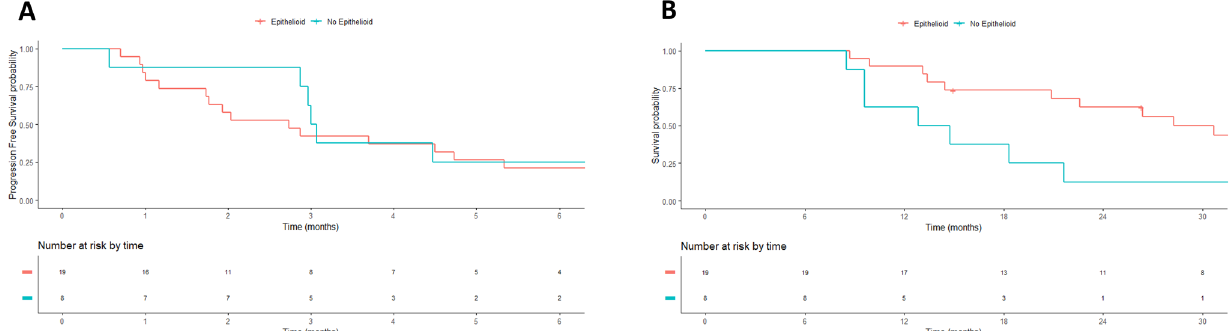
Figure 4. Kaplan–Meier Survival according to histology in patients treated with cancer immunotherapy: PFS ( A ) and OS ( B ).